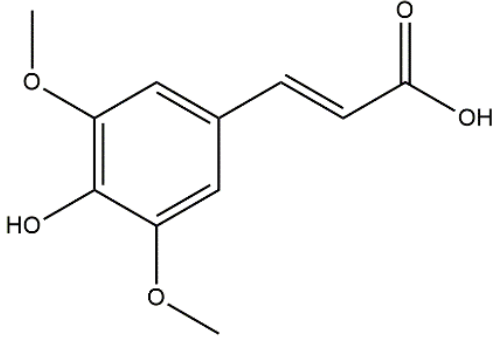
Figure 7. Chemical structure of sinapic acid ( 4 ).